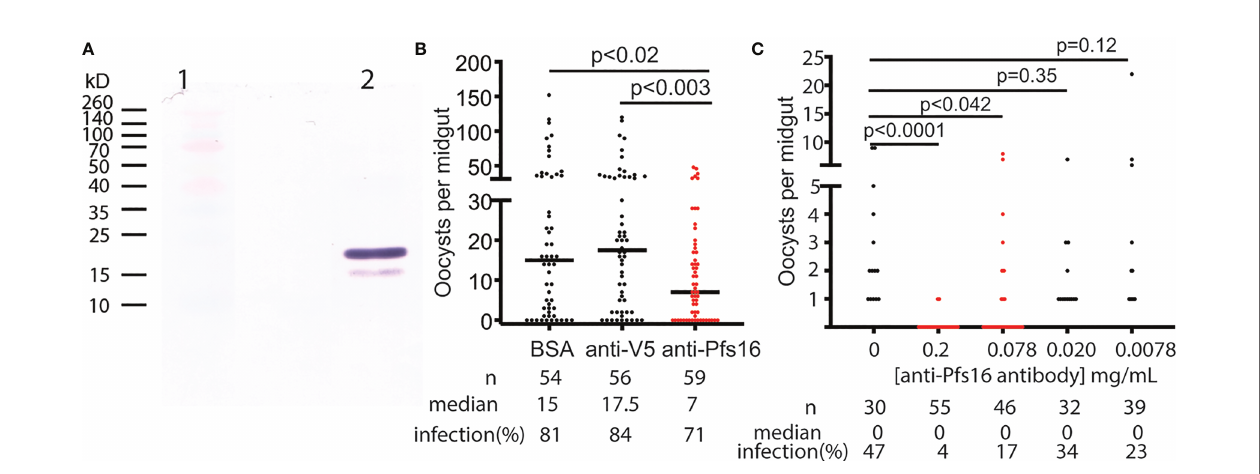
FIGURE 5 | The functional analysis of Pfs16 on Plasmodium transmission to mosquitoes. (A) Western blot assay showed that anti-Pfs16 antibody speci fi cally recognized the insect cell-expressed recombinant Pfs16 protein in lane 2. Two bands in lane 2 are the precursor and mature forms of Pfs16 with His- and V5-tag Lane 1 displayed standard protein markers with some color proteins. (B) Rabbit anti-Pfs16 polyclonal antibody inhibited P. falciparum transmission to An. gambiae by SMFA. The same concentration of BSA and an unrelated antibody (anti-V5) were used as the controls. The p-values between the experimental and the control groups were calculated using Wilcoxon-Mann-Whitney tests. The assays were repeated, and the results were similar. Horizontal bars are the median numbers of oocysts per mosquito midguts. (C) The antibody inhibition on malaria transmission was dose-dependent. This experiment was repeated twice, and the results were similar.